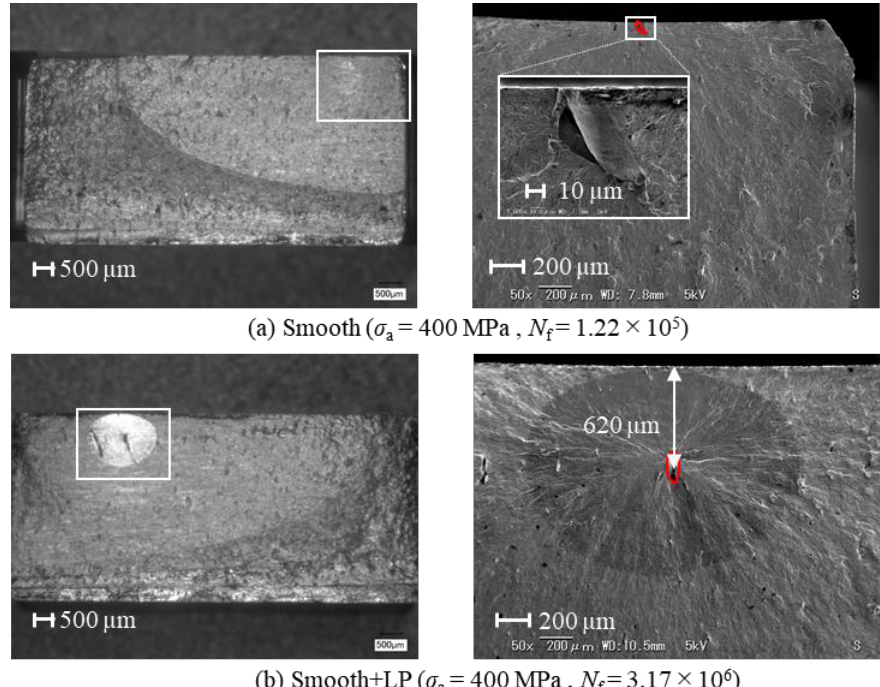
Figure 8. Fracture surface of the ( a ) Smooth and ( b ) Smooth + LP specimen.